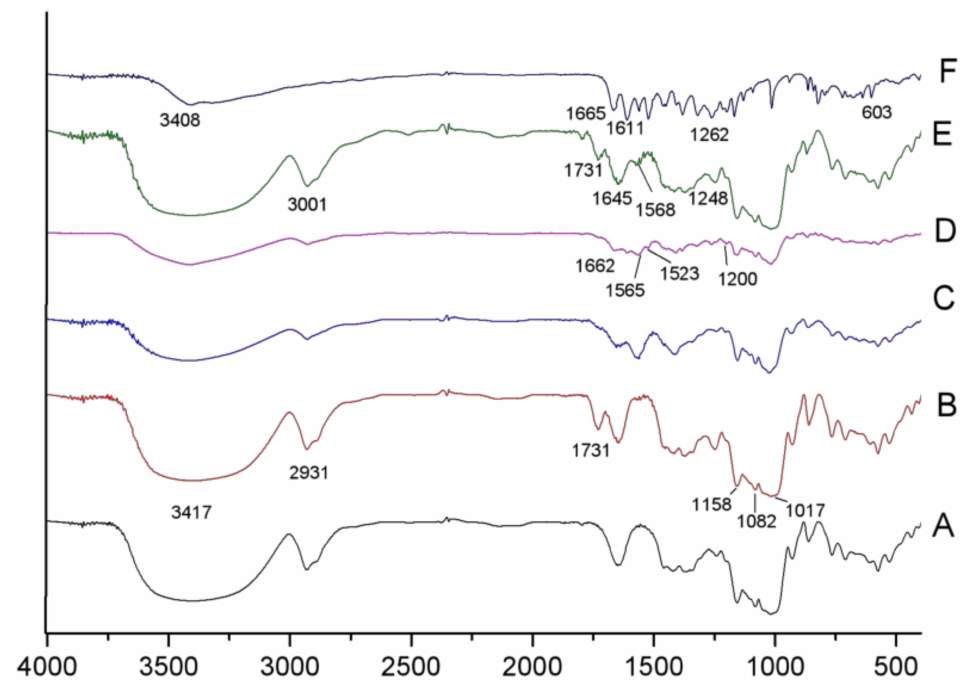
Figure 3. FT-IR spctra of ( A ) native cassava starch; ( B ) CA; ( C ) OSA-CA; ( D ) the mixture OSA-CA and Q; ( E ) OSA-CA/Q; ( F )